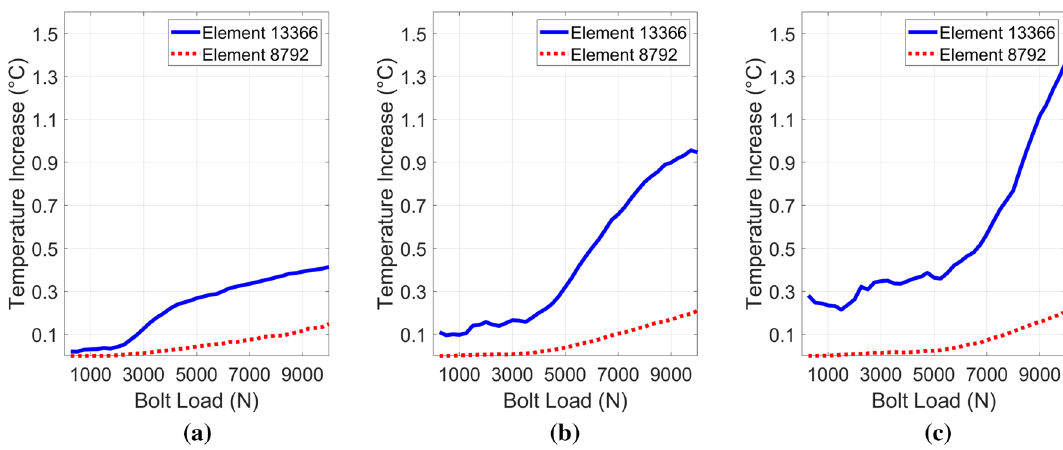
Fig. 10 Temperature increase (°C) over 0.05 s with a 500 N, b 1000 N and c 1500 N excitation amplitude, the first mode of